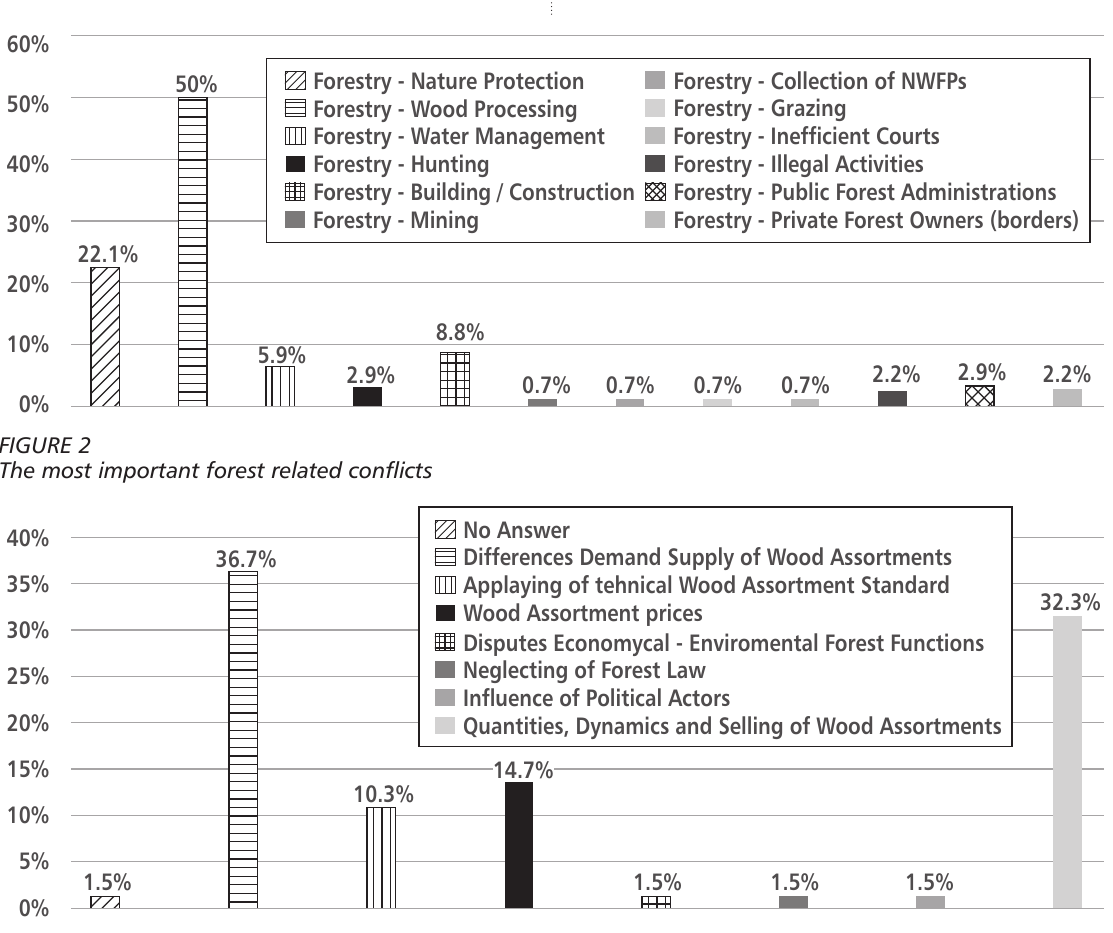
FIGURE 3 Main cause of the conflict between forestry and wood processing